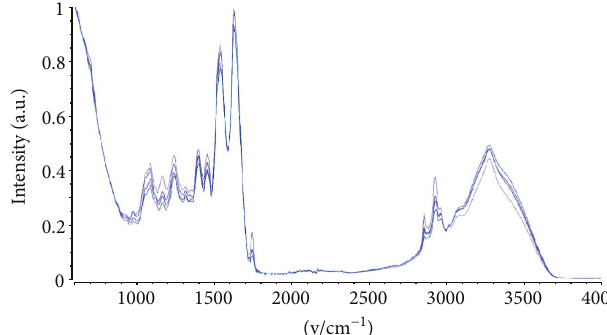
Figure 1: FT-IR spectra of fresh salmon muscle sampled from areas exhibiting two distinctive fl esh colors: brown and pink.